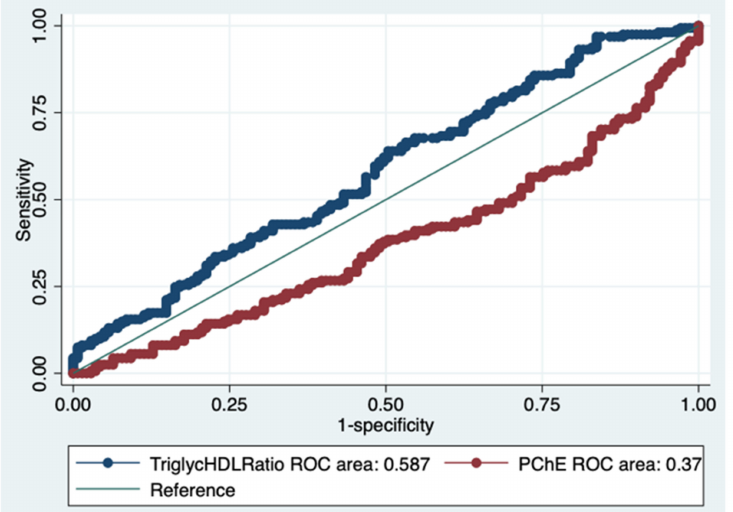
Figure 5. Comparison of the two ROC areas, i.e., the TG/HDL ratio and the pseudocholinesterase levels, as performance evaluation measures. The TG/HDL ratio showed a higher AUCROC than that of the pseudocholinesterase